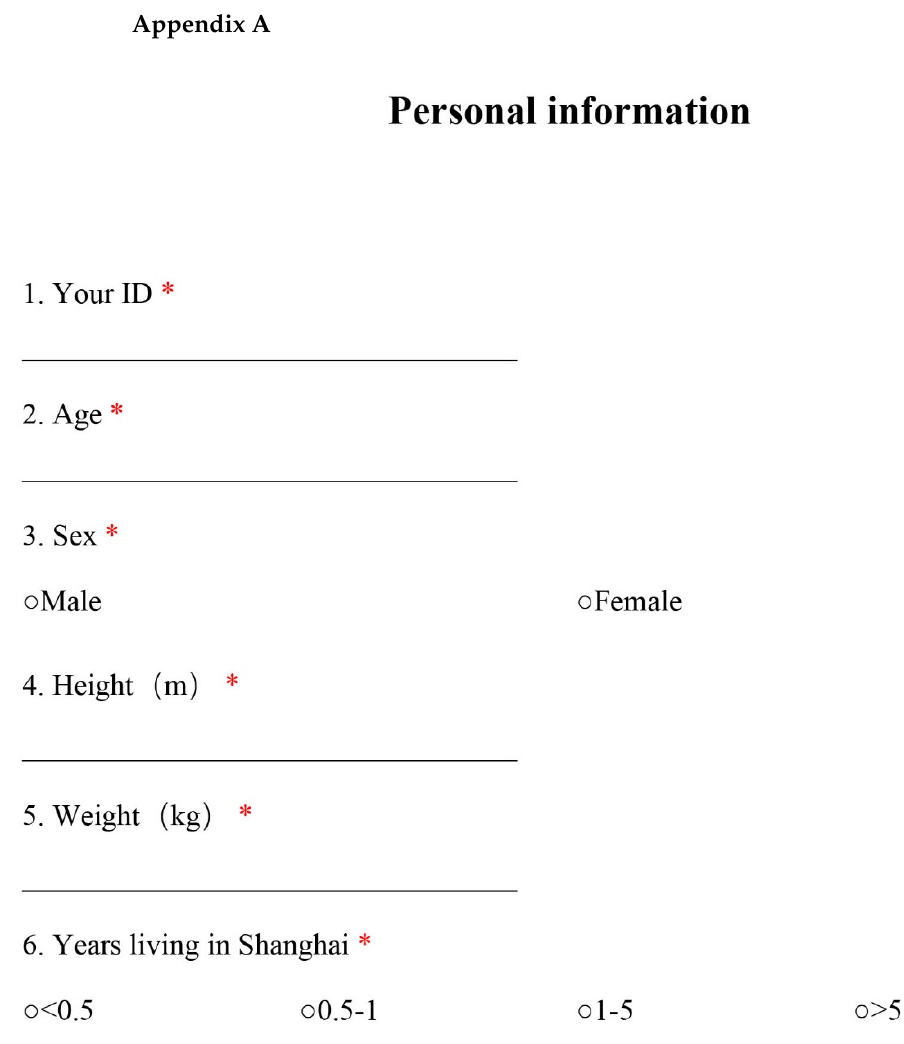
Figure A1. Personal information questionnaire.